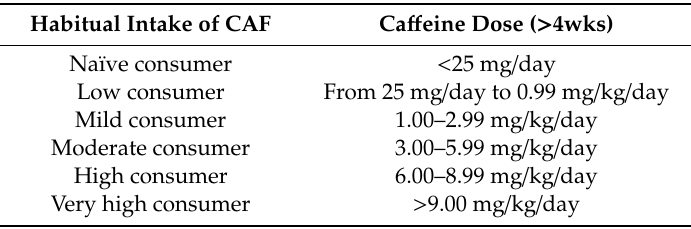
Table 2. Proposed thresholds for classifying individuals in sport performance research according to their habitual ca ff eine